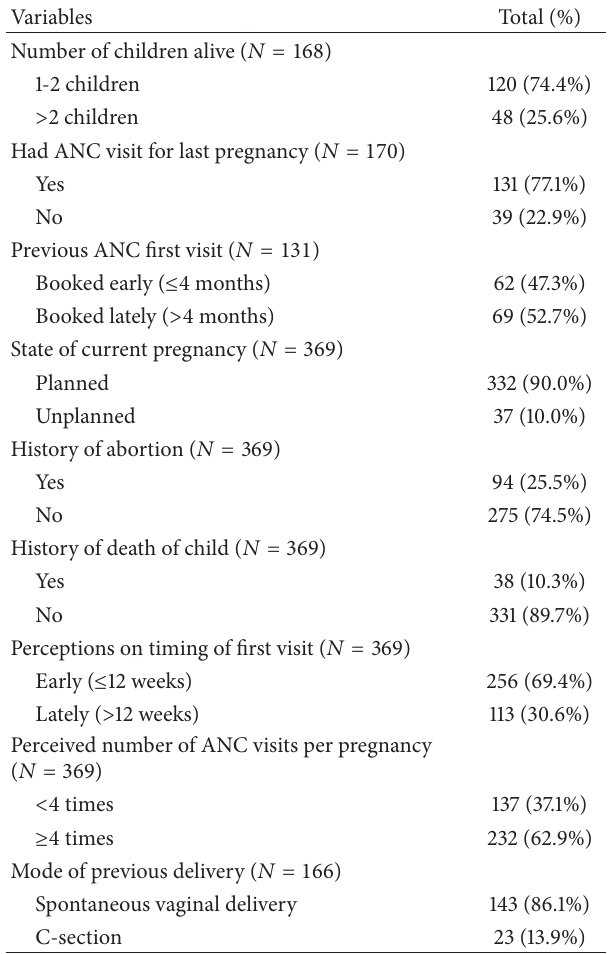
Table 1: Sociodemographic characteristics of pregnant mothers by time of booking, University of Gondar Hospital, Northwest Ethiopia, 2013 ( 𝑁 = 369 ).